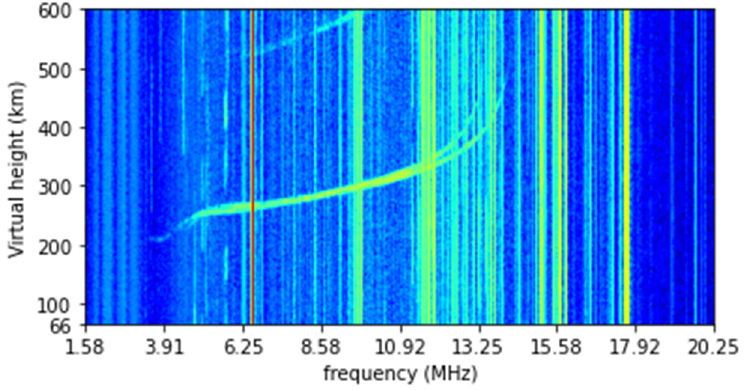
Figure 2. Downsized ionogram image.